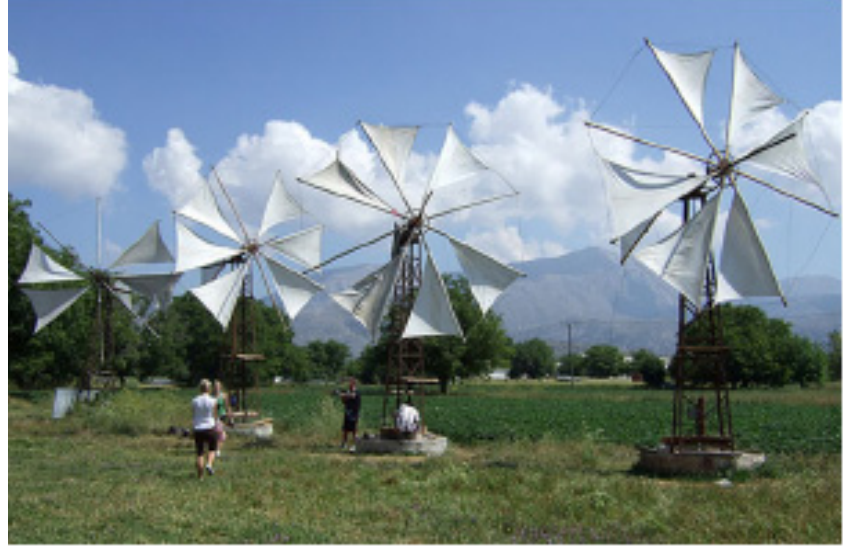
Figure 17. Water pumping sail-wing machines in the plateau of Lassithi in the Island of Crete (adapted from